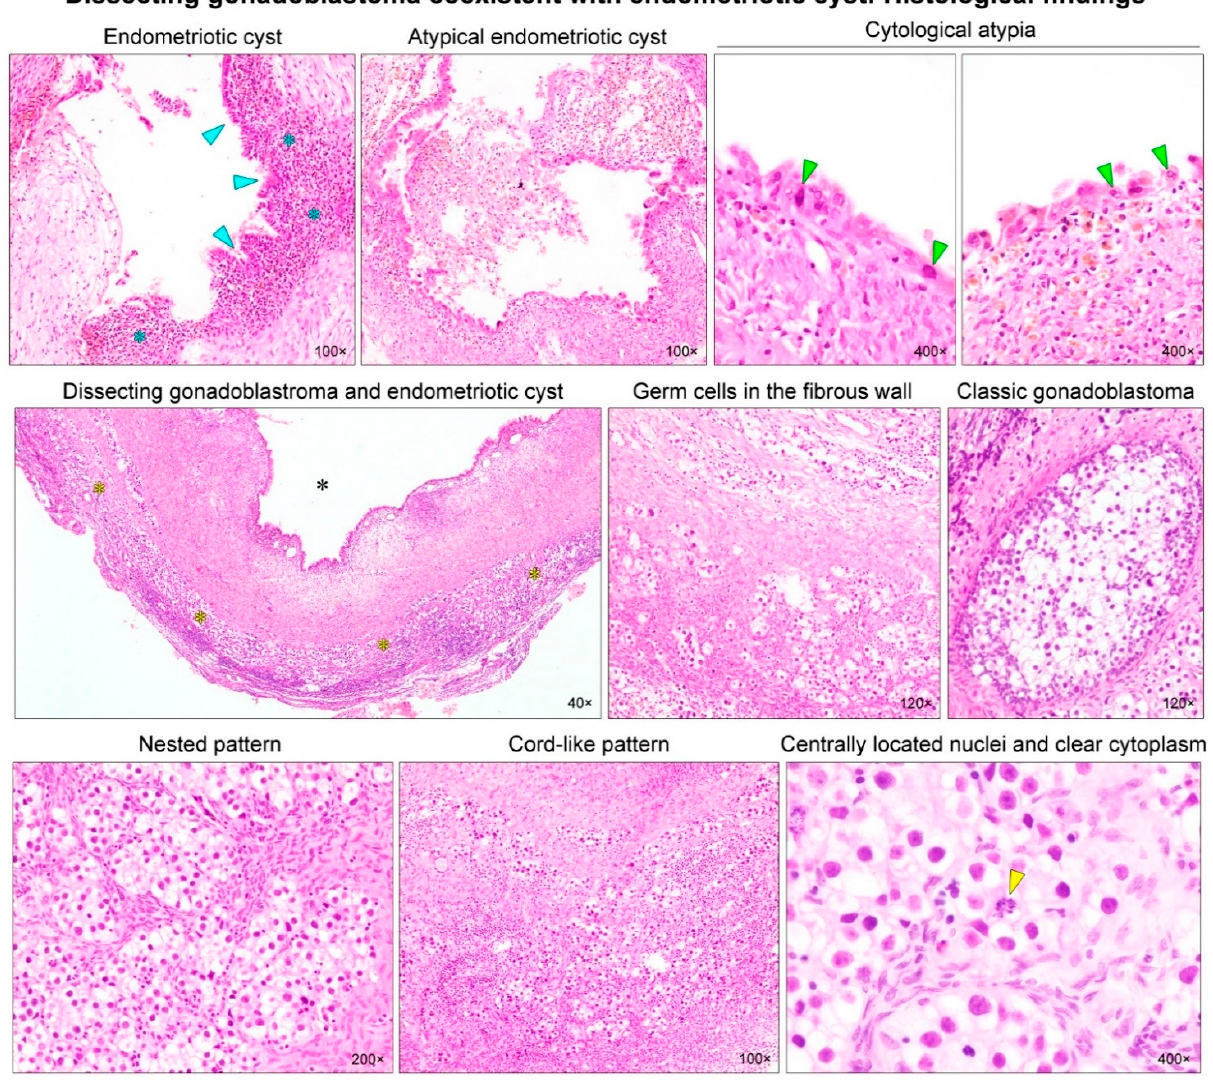
Figure 2. Histological findings. The left ovarian cyst measured 4.8 cm at its greatest dimension, with a smooth and glistening external surface. Serial sections revealed an irregularly thickened unilocular cystic wall and chocolate-like fluid. No solid component or necrosis was identified. Histologically, the inner surface of the cyst was lined by endometrial-like glands (blue arrowheads) and stroma (blue asterisks). In some foci, the glandular epithelial cells showed variable degrees of cytological atypia (green arrowheads), including nuclear enlargement and hyperchromasia, abundant eosinophilic cytoplasm with occasional intracytoplasmic hemosiderin and mucin vacuoles, and low nuclear-to-cytoplasmic ratio. Architectural distortion or confluent glandular crowding was absent. These histological features were compatible with an atypical endometriotic cyst. In addition, numerous germ cells resembling those of ovarian dysgerminoma were diffusely distributed within the ovarian stroma (yellow asterisks), which was stretched around the wall of the endometriotic cyst (black asterisk). A few foci of classic gonadoblastoma were seen. Although most of the neoplastic germ cells formed small nests, some were arranged in cords or trabeculae. Under high-power magnification, the cells possessed clear cytoplasm and were centrally located around the nuclei with occasional prominent nucleoli. Mitotic figures (yellow arrowhead) were readily identifiable.